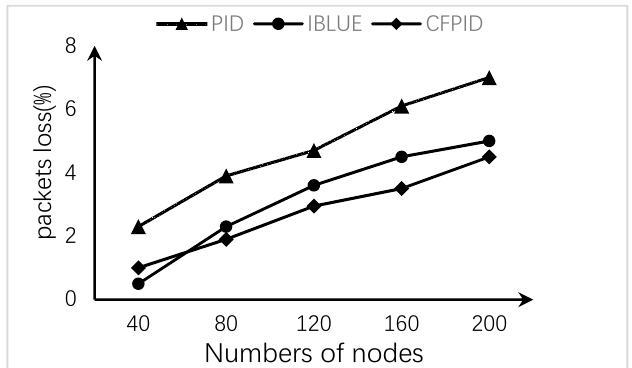
Figure 10. Packet loss rate curve.